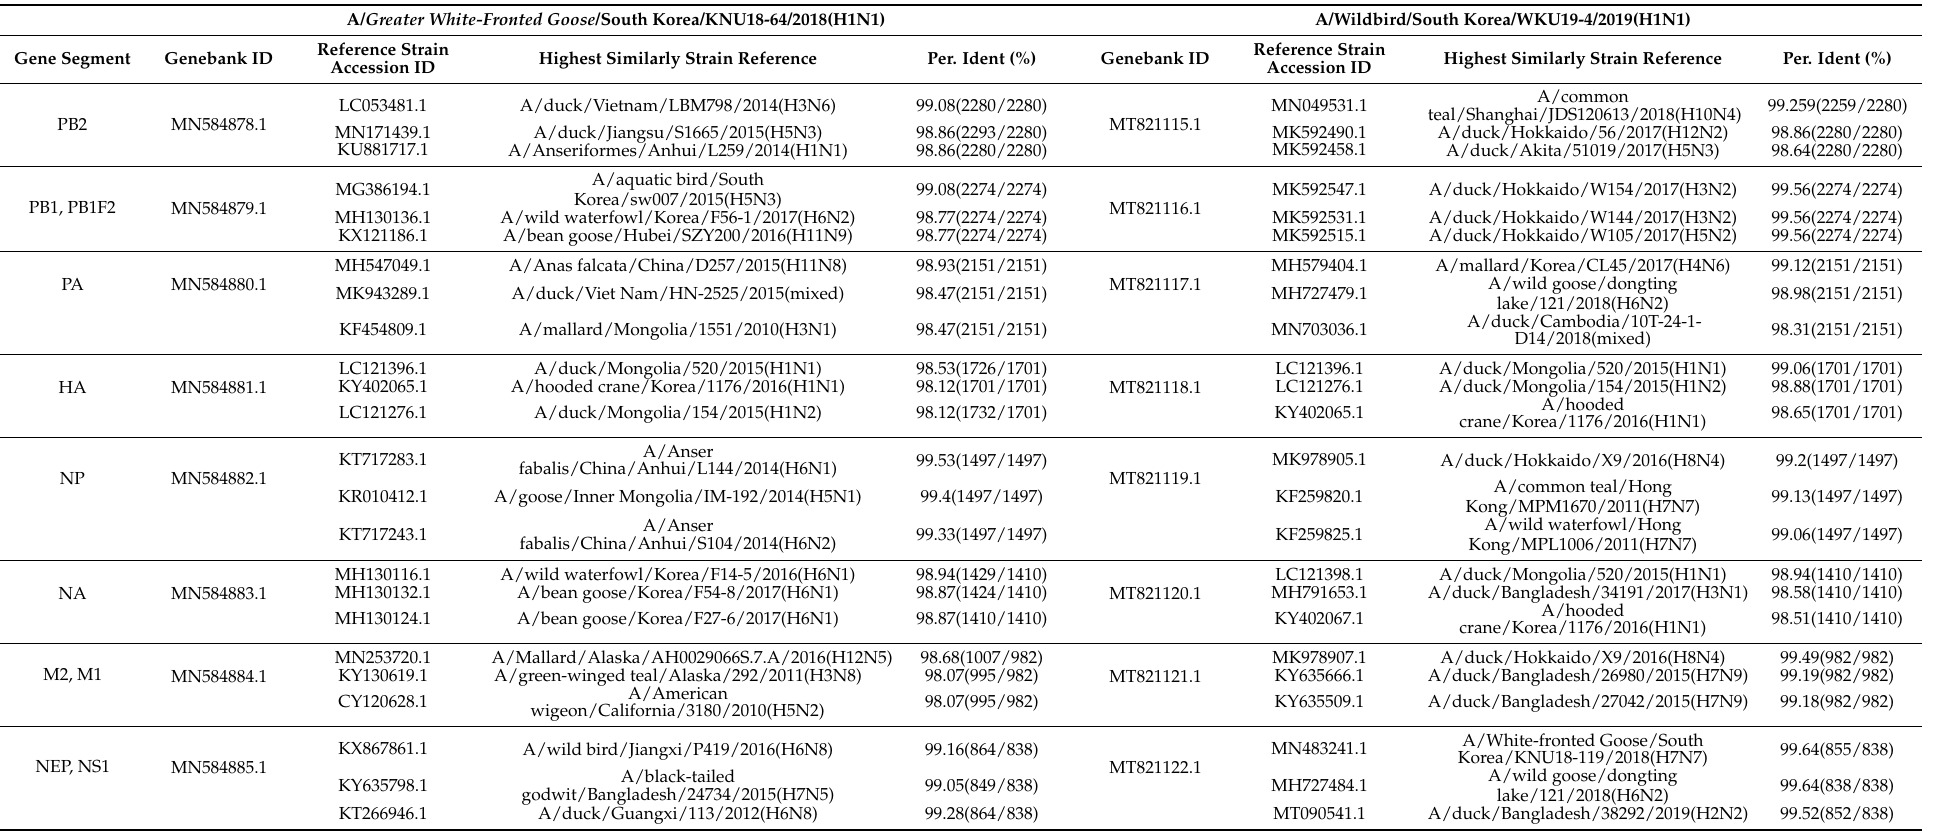
Table 1. Virus strains from the GenBank database with the highest nucleotide identities with the two H1N1 isolates investigated in the present study. A/ Greater White-Fronted Goose /South Korea/KNU18-64/2018(H1N1) A/Wildbird/South